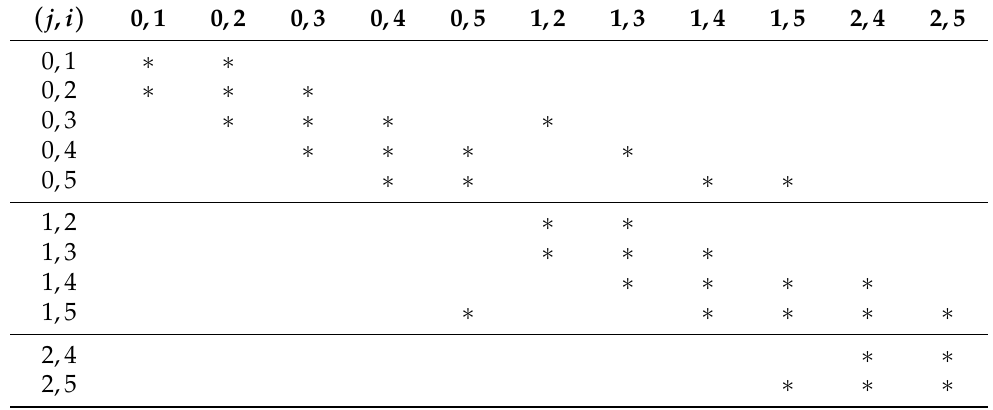
Table A1. Block structure of nonzero elements (marked by ∗ ) of the system of state equations of r ba ( t ) for the case v = 5, N = 2, L ( 0 ) = 1, L ( 1 ) = 2, L ( 2 ) =